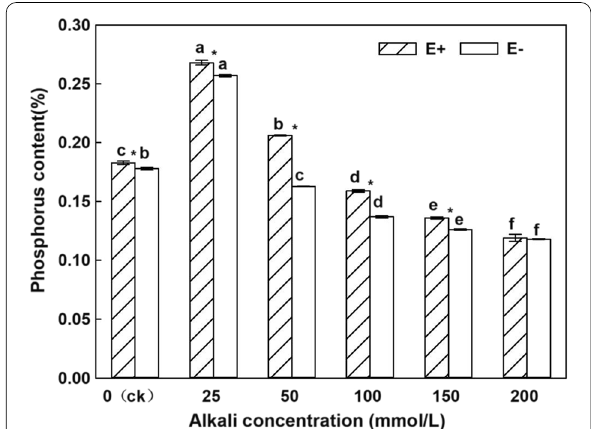
Fig. 1 Phosphorus content in E and E Hordeum bogdanii roots + − under different concentrations of alkaliIn different treatments, in the same E or E , different lowercase letters show significant + − differences ( P < 0.05); in the same treatment of E and E , significant + − differences between pairs are indicated by "*" ( P < 0.05), as shown above.